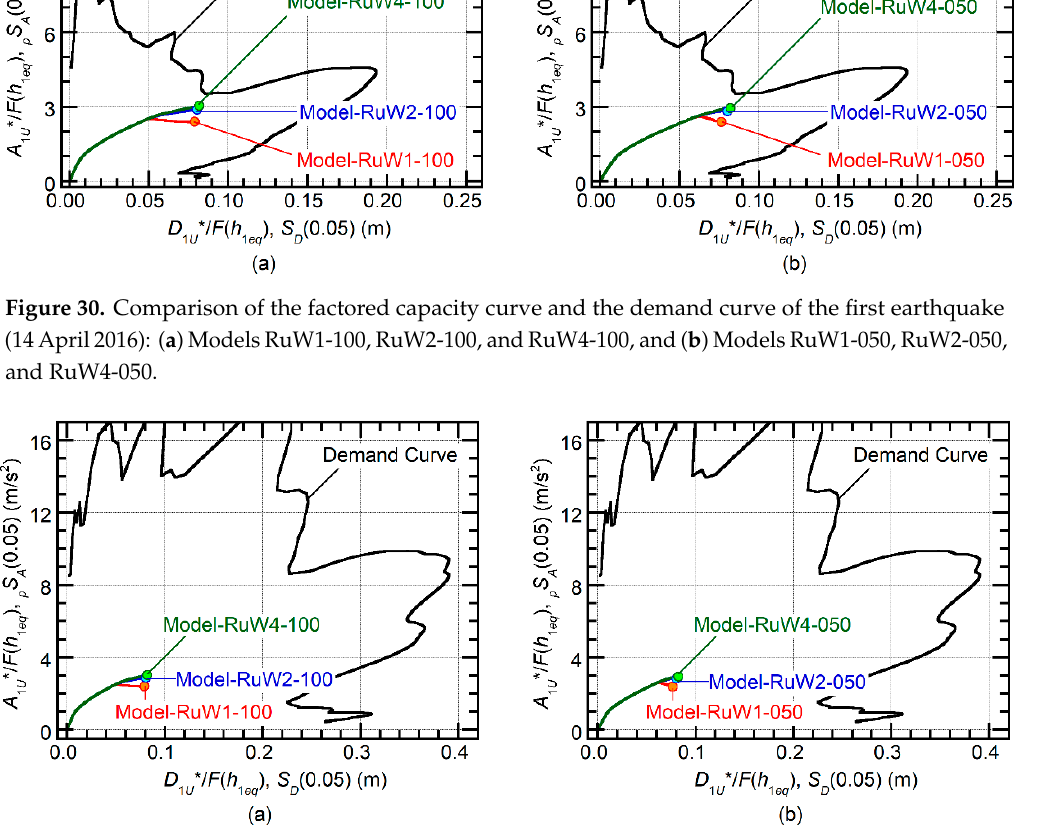
Figure 31. Comparison of the factored capacity curve and the demand curve of the second earthquake (16 April 2016): ( a ) Models RuW1-100, RuW2-100, and RuW4-100, and ( b ) Models RuW1-050, RuW2-050, and RuW4-050.